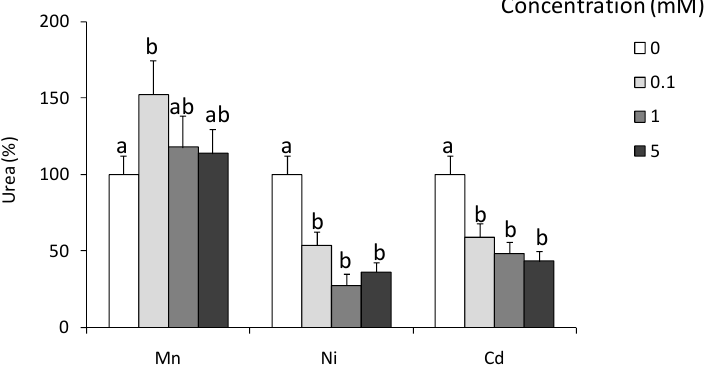
Figure 3. Effects of in vitro treatment with heavy metals on arginase activity in Eisenia andrei coelomo- cytes. Cells were in vitro treated for 24 h with different concentrations of Ni, Cd, and Mn chloride (0.1, 1, or 5 mM). Arginase activity was determined as urea content and showed as % of control (arginase activity in unstimulated cells = 100%). Mean + SE, n = 4–10. Mean values that are significantly different are not assigned a common letter (e.g., a vs. b or b vs. c) according to one-way analysis of variance (ANOVA) (at p < 0.05).